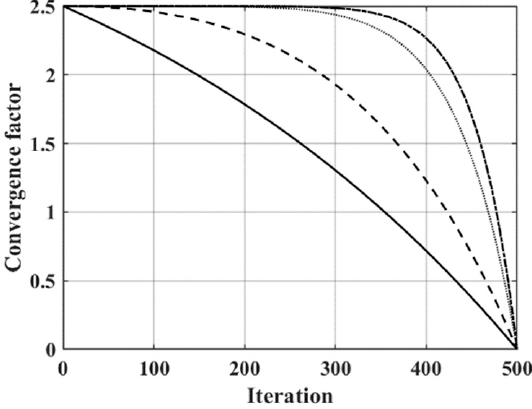
Figure 4. Comparison curve of convergence factors.